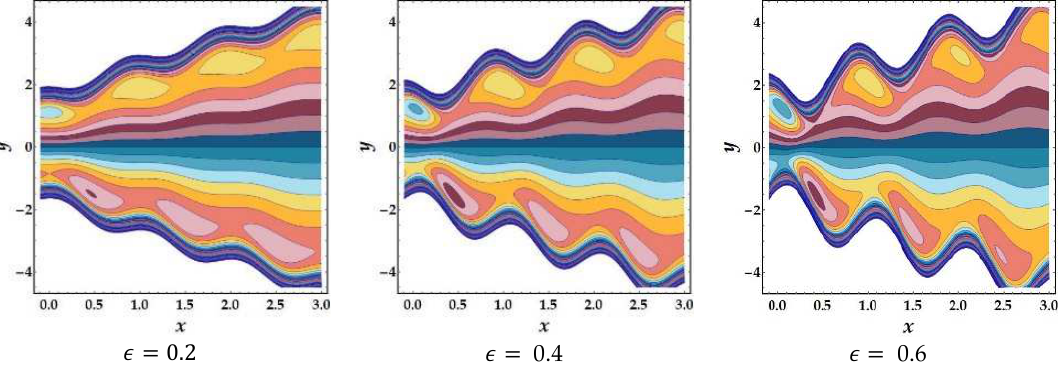
Figure 10. The behavior of Streamlines for different values of cilia length parameter (cid:101) .